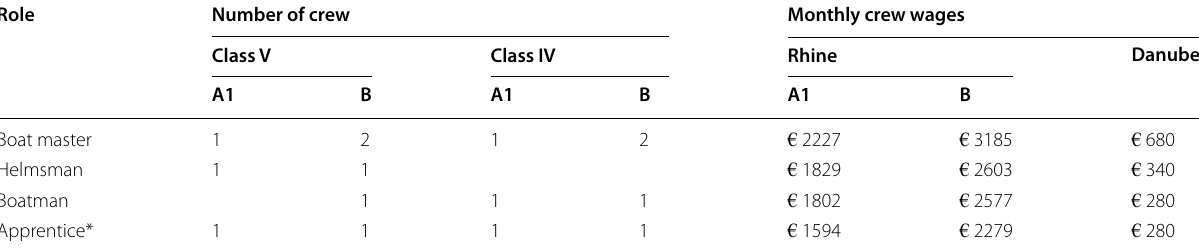
Table 10 Number of crew and wages summary for the Rhine and Danube case